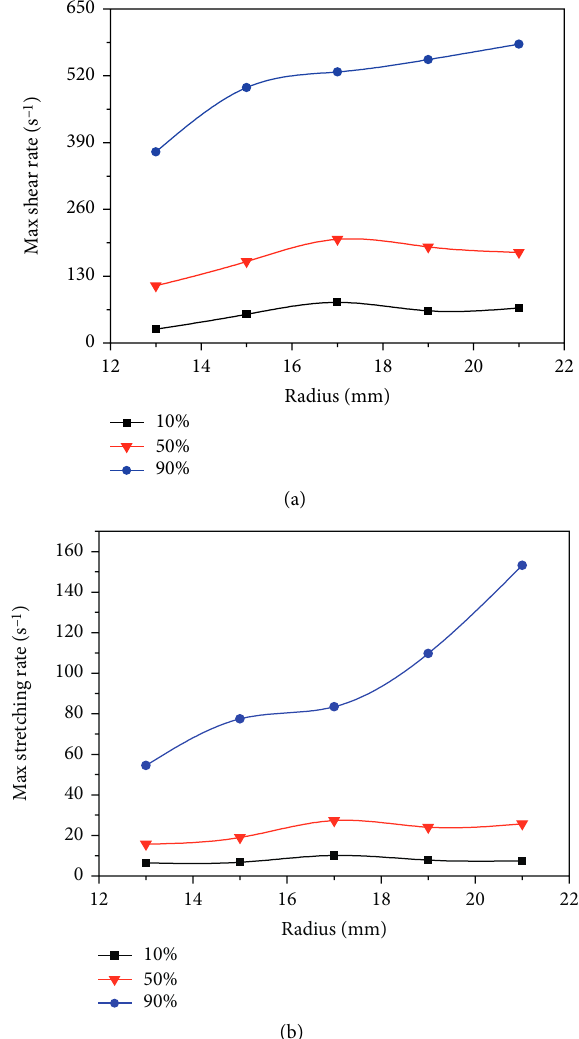
Figure 10: Influence of rotor radius on the maximum shear rate (a) and stretching rate